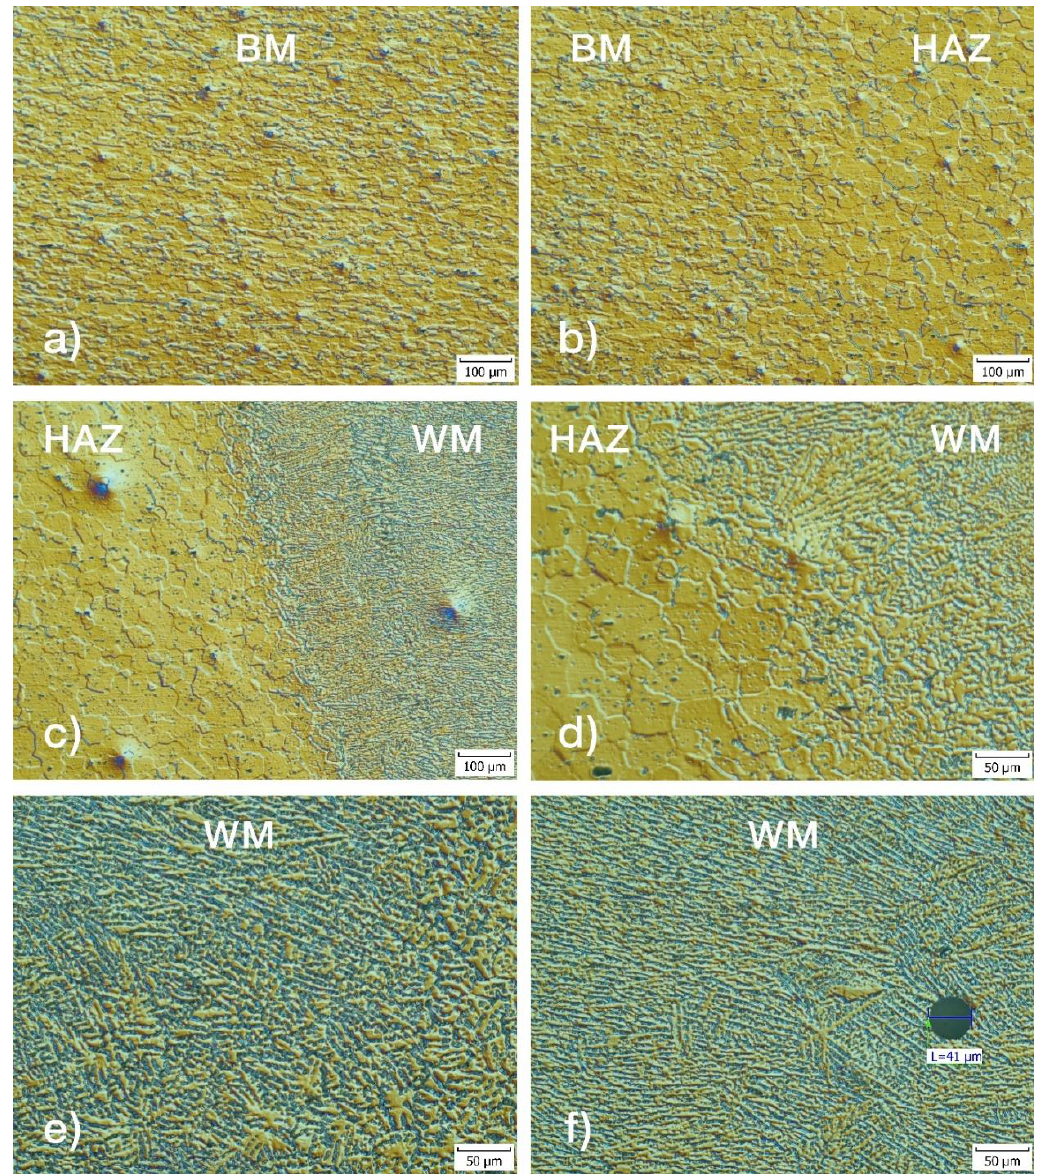
Figure 5. Optical microscope images of the microstructure of ( a ) base material (BM); ( b ) BM–heat affected zone (HAZ); and ( c ) HAZ–weld metal (WM); ( d ) a higher magnification of ( c ); ( e ) the WM of